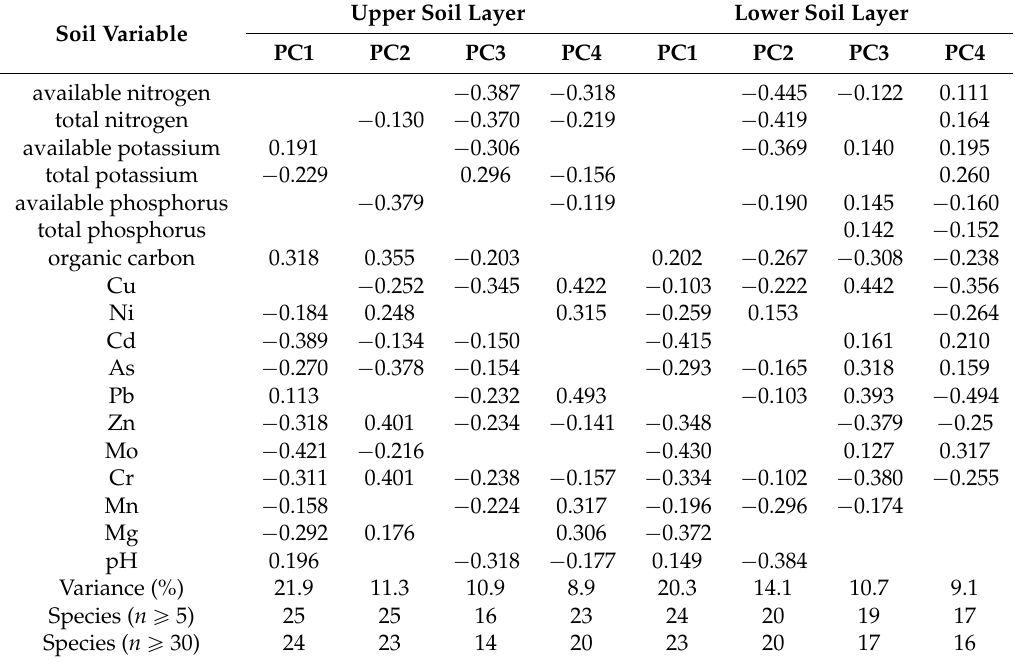
Table 2. Soil variable loadings on the four principal components (PCs) in the two soil layers. Upper Soil Layer Lower Soil Layer Soil Variable PC1 PC2 PC3 PC4 PC1 PC2 PC3 PC4 available nitrogen ´ 0.387 ´ 0.318 ´ 0.445 ´ 0.122 0.111 total nitrogen ´ 0.130 ´ 0.370 ´ 0.219 ´ 0.419 0.164 available potassium 0.191 ´ 0.306 ´ 0.369 0.140 0.195 total potassium ´ 0.229 0.296 ´ 0.156 0.260 available phosphorus ´ 0.379 ´ 0.119 ´ 0.190 0.145 ´ 0.160 total phosphorus 0.142 ´ 0.152 organic carbon 0.318 0.355 ´ 0.203 0.202 ´ 0.267